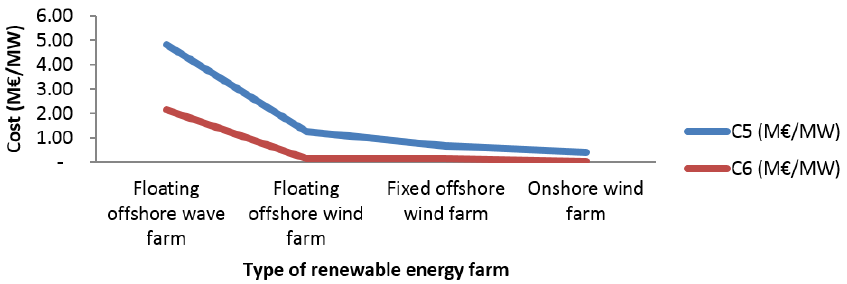
Figure 15. Comparison operation (C5) and decommissioning (C6) costs of several renewable energy farms.